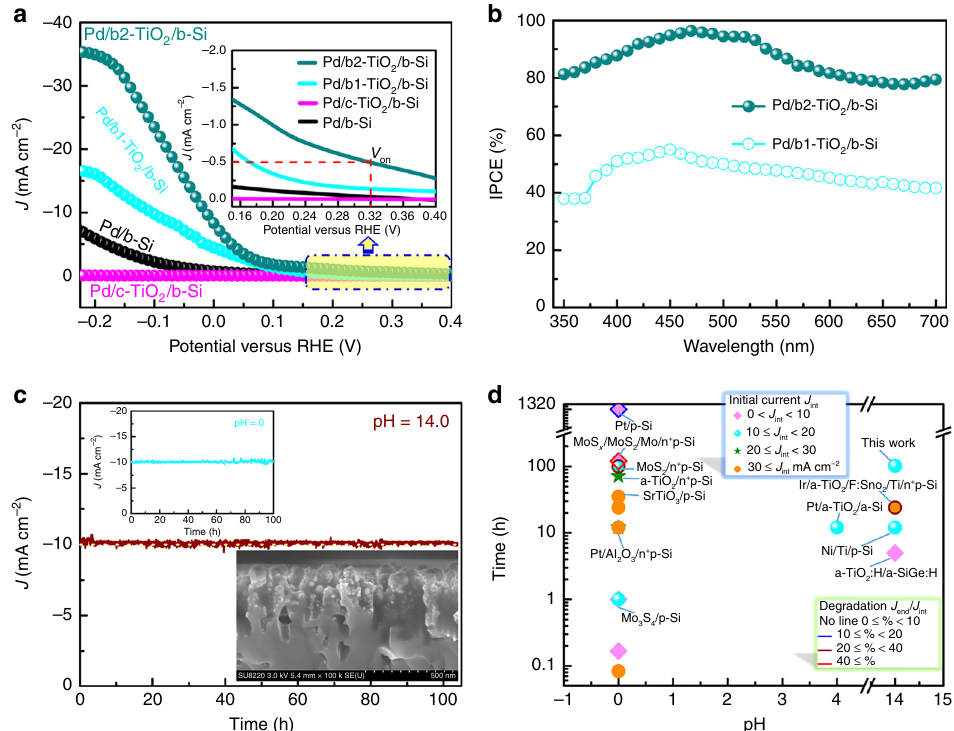
Fig. 5 PEC performance of Pd/b-Si, Pd/c-TiO 2 /b-Si, Pd/b1-TiO 2 /b-Si and Pd/b2-TiO 2 /b-Si. a Current density ( J )-potential ( V ) curves of all the samples (scan rate is 0.01 V s − 1 ) in 1.0 M NaOH under 1 sun illumination. The current density measured in dark is almost horizontal line, namely 0 mA cm − 2 . The inset is the high magni fi cation image corresponding to the marked area. b IPCE of Pd/b1-TiO 2 /b-Si and Pd/b2-TiO 2 /b-Si in 1.0 M NaOH at − 0.22 V vs RHE. c J -time ( t ) plot of Pd/b2-TiO 2 /b-Si held at − 0.012 V vs RHE in 1.0 M NaOH under 1 sun illumination. The upper-left inset is J – t plot of Pd/b2-TiO 2 /b- Si held at − 0.124 V vs RHE in 0.5 M H 2 SO 4 under 1 sun illumination. The bottom-right inset is cross-sectional FESEM image of Pd/b2-TiO 2 /b-Si after 100 h PEC water splitting in 1.0 M NaOH. d Chart visualizing data on stabilities of photocathodes including previous and current work, versus tested pH condition, with resulting photocurrent and degradation rate indicated. Most of device structures for the photocathode with reported stability longer than one hour are noted. J int is the initial photocurrent at the start of the stability test. Degradation rates are calculated using the ratio of the measured photocurrent at the end of the stability test ( J end ) to J to initial J of ~10 mA cm − 2 ) in 1.0 M NaOH and 0.5 M H 2 SO 4 solutions (Fig. 5c). Pd/b2-TiO 2 /b-Si photocathodes exhibit little